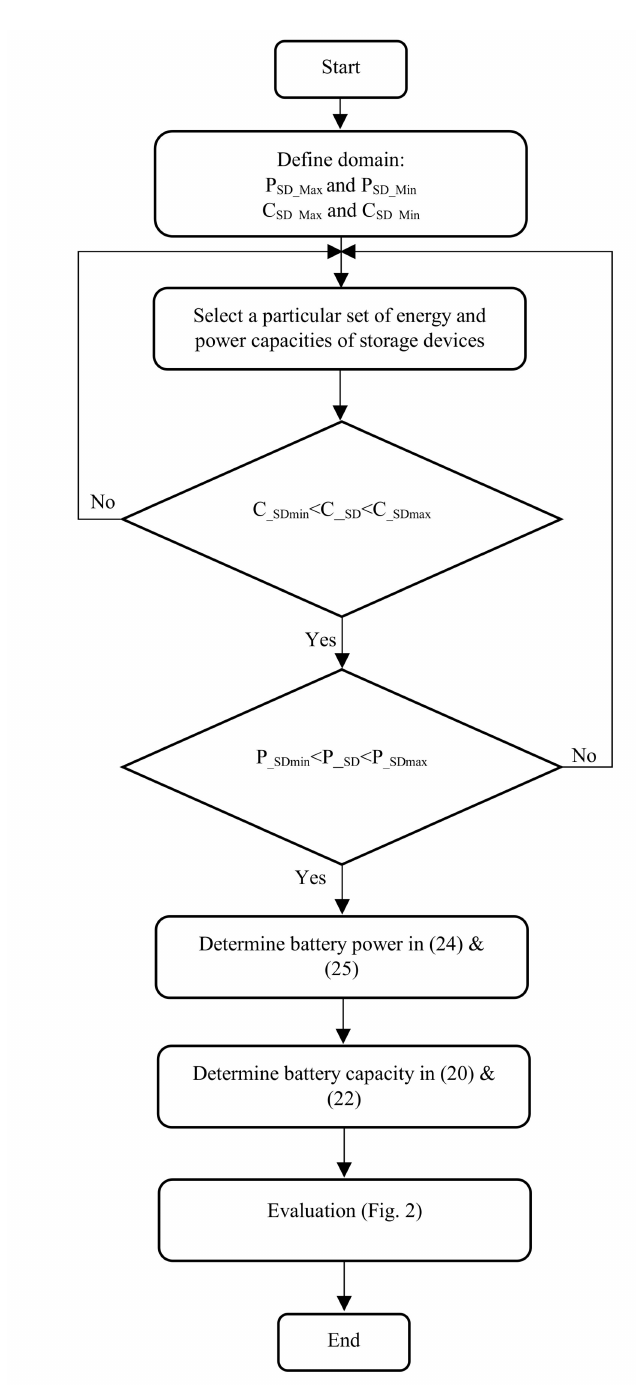
Figure 3. Flowchart of sizing